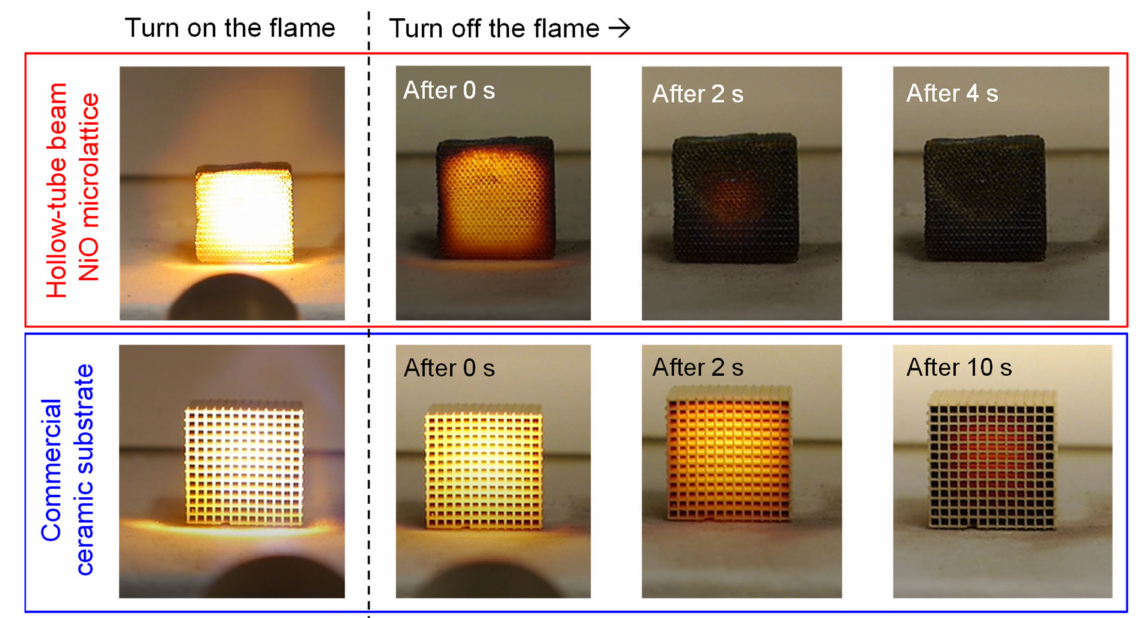
Figure 6. Optical images of hollow-tube NiO microlattices and conventional ceramic monolith subjected to the butane blowtorch